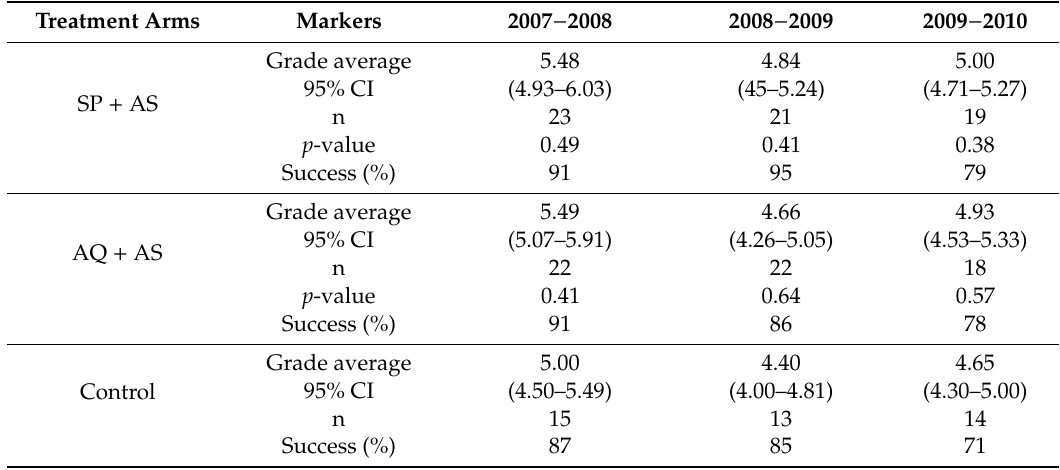
Table 4. Markers of School Performance in Each Study Year in The Treatment